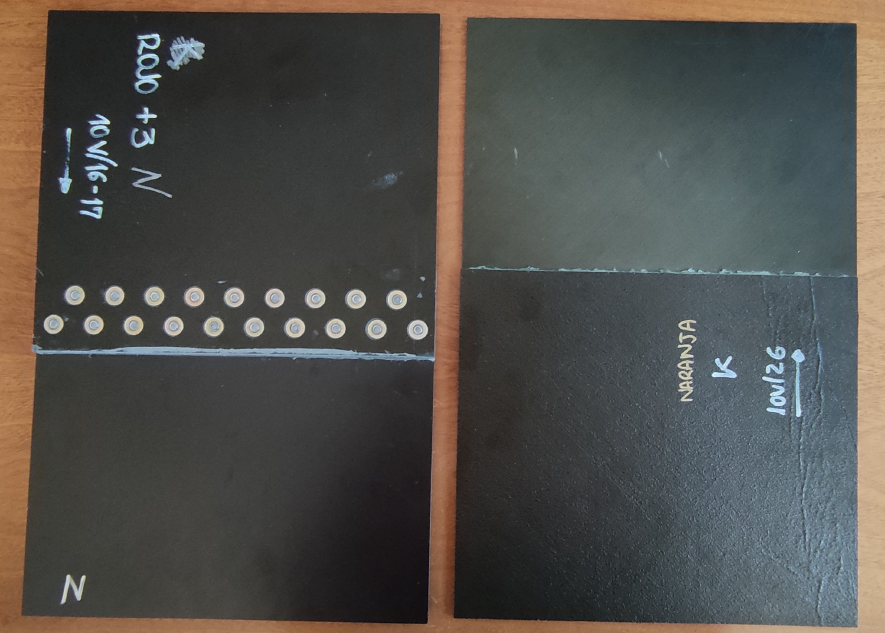
Figure 2. Microstrip test pieces: CFC fastener joint code named “RED+3/RED+3” ( left ) and CFC adhesive joint code named “ORANGE/ORANGE” ( right